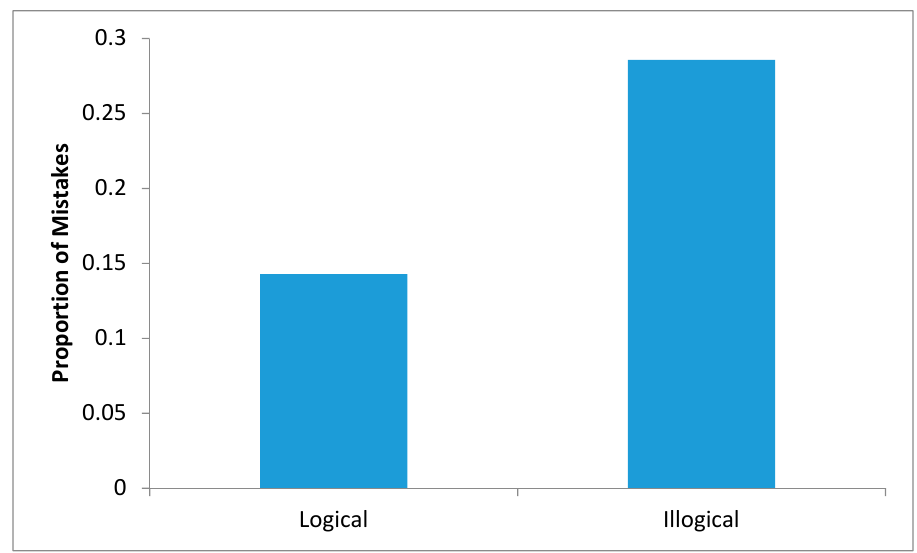
Figure 10. Comparing mistakes made in performing logical and illogical task sequences.